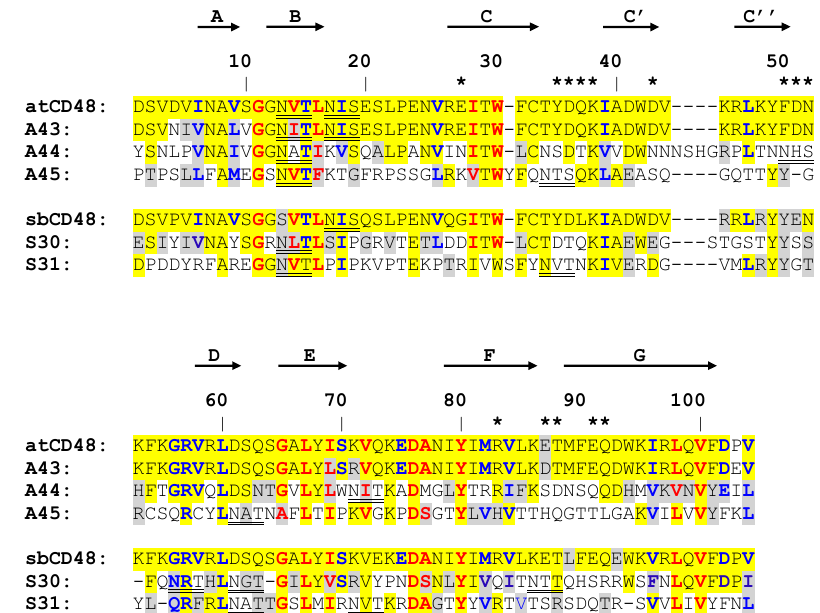
Figure 5. Alignment of the N-terminal Ig domains of vCD48s and host CD48s. The predicted β-strands are depicted with arrows at the top and labeled using the standardized nomenclature for Ig-like domains: A, B, C, C’, C”, D, E, F, and G. Potential N-linked glycosylation sites are double underlined. Conserved residues (with respect to CD48) are shaded in yellow (identical amino acid) or light gray (similar amino acid). Amino acids colored in bold red are conserved between most members of the Ig superfamily; those colored in bold blue are conserved between most SLAM family receptors. Contacting residues in the 2B4:CD48 heterophilic dimer are marked using black stars above the atCD48 sequence.